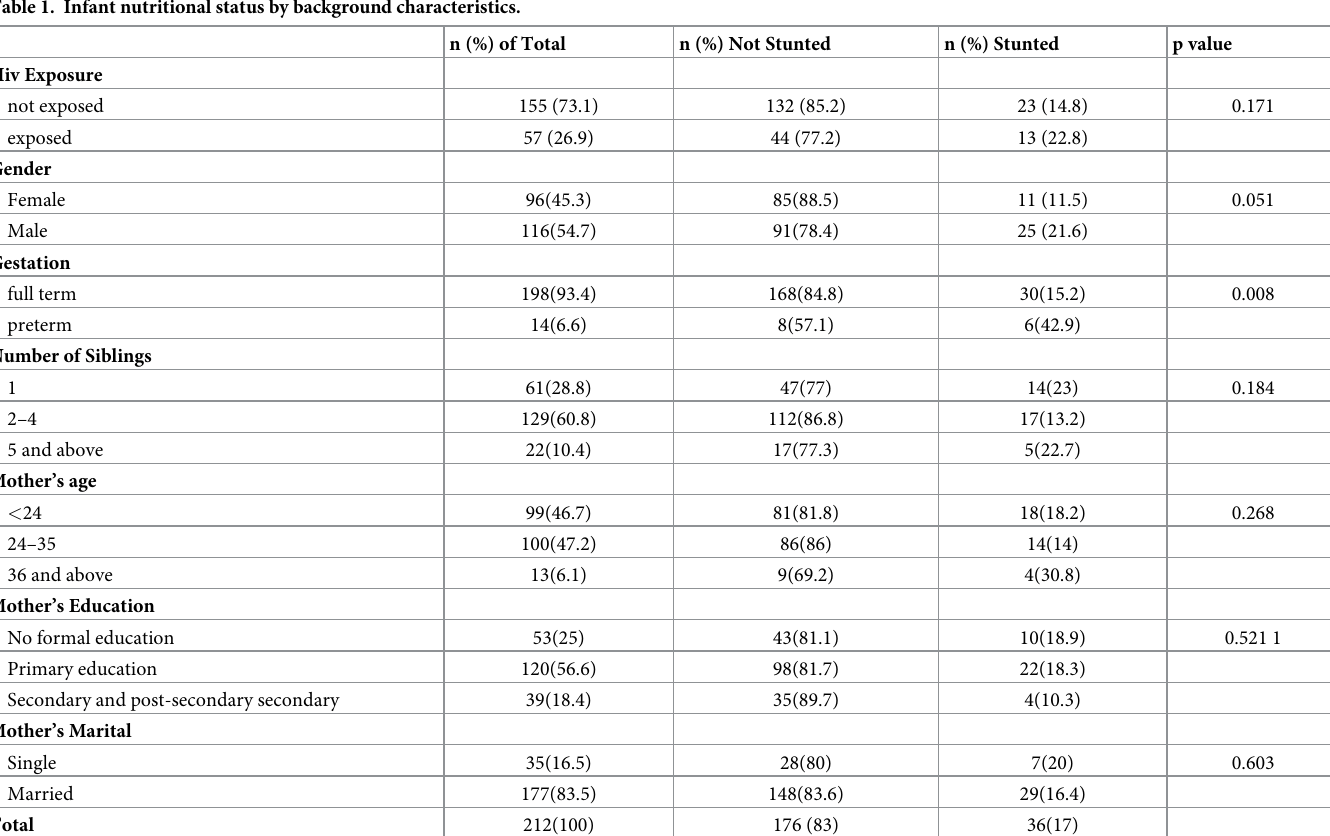
Table 1. Infant nutritional status by background